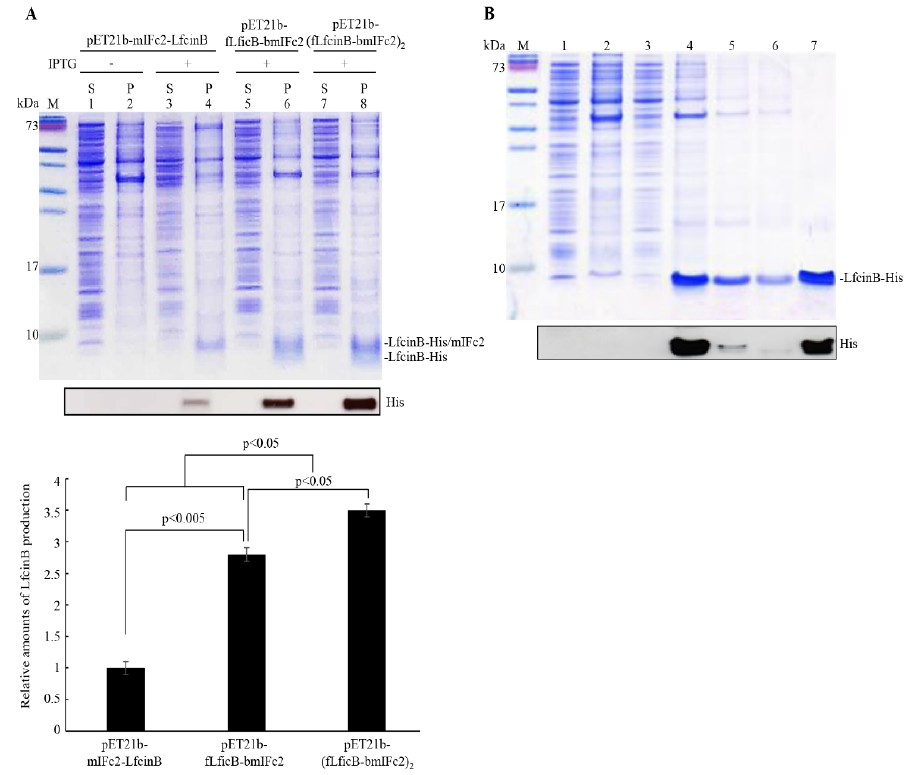
Figure 5. Co-expression of mIFc2 and LfcinB-His. ( A ). The expression vector pET21b-mIFc2-LfcinB was transformed into E. coli C43(DE3). The co-expressed proteins of mIFc2 and His-LfcinB were analyzed by Western blot with the anti-His antibody and HRP-conjugated secondary antibody, respectively. After induction by 200 nM IPTG for 3 h at 30 ◦ C, the negatively charged mIFc2 (7 kDa) and LfcinB (3.9 kDa) were analyzed by a 16.5% tricine SDS-PAGE (upper panel). After changing the order of the mIFc2 and LfcinB, the expression levels of LfcinB-His could be further increased using the pET21b-fLfcinB-bmIFc2 plasmid. The expression levels of LfcinB by the pET21b-(fLfcinB-bmIFc2) 2 vector was higher than that of the pET21b-mIFc2-LfcinB and pET21b-fLfcinB-bmIFc2 vectors. The expression levels of LfcinB-His by pET21b-mIFc2-LfcinB were considered 1-fold. Signals for all blots in upper panel (lanes 4, 6, 8) were quantified using ImageJ software. All experiments were conducted in three independent experiments. ( B ) The co-expressed LfcinB-His and mIFc2 protein by the pET21b-(fLfcinB-bmIFc2) 2 vector was induced in E. coli C43(DE3) followed by induction with IPTG (200 mM) for 3 h at 30 ◦ C. LfcinB-His was purified by a Nickle affinity column. Lane M: